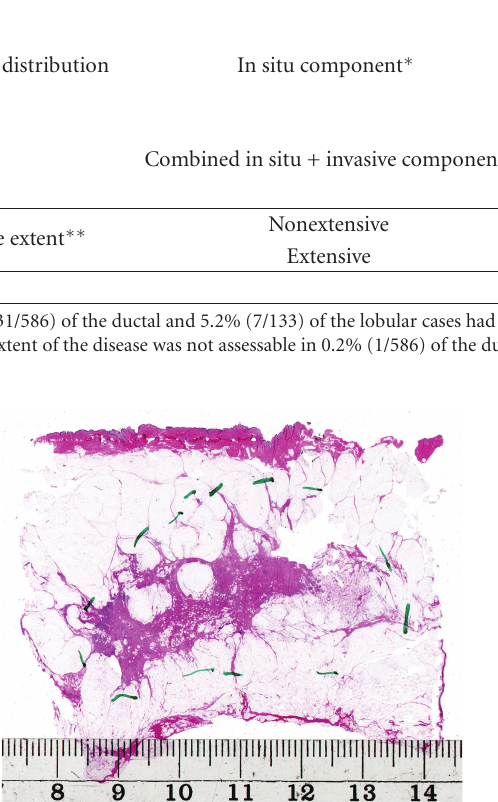
Figure 3: Large-format histology section showing a di ff use invasive carcinoma of the